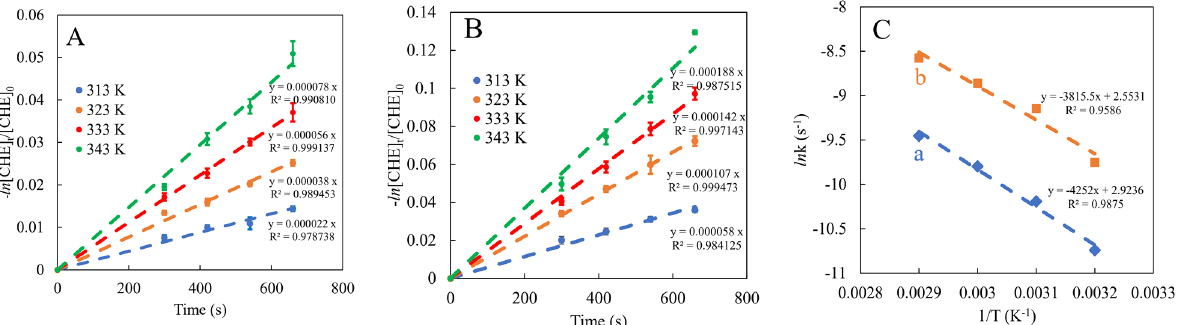
Figure 10. Kinetic analysis of cyclohexene epoxidation over Ti − Beta ( A ) and Re − Ti − Beta ( B ). Plots of apparent activation energy ( C ) in the cyclohexene epoxidation catalyzed by Ti − Beta (a) and Re − Ti − Beta − 0.20 (b) catalysts. Reaction conditions: catalyst, 0.05 g; cyclohexene, 10 mmol; H 2 O 2 (30 wt.%), 10 mmol; MeCN, 10 mL.